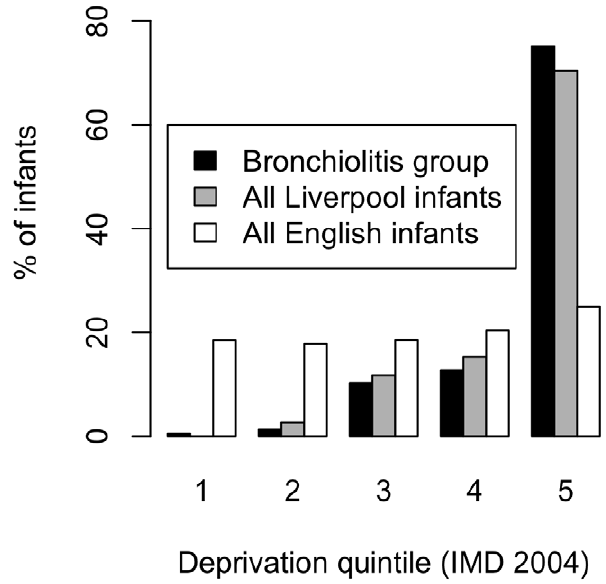
Figure 1. Proportion of infants by deprivation quintile. Deprivation quintiles (1 least deprived, 5 most deprived); infants recruited to this study with bronchiolitis (black), all Liverpool infants in 2001 census (grey) and all English infants in 2001 census (white).